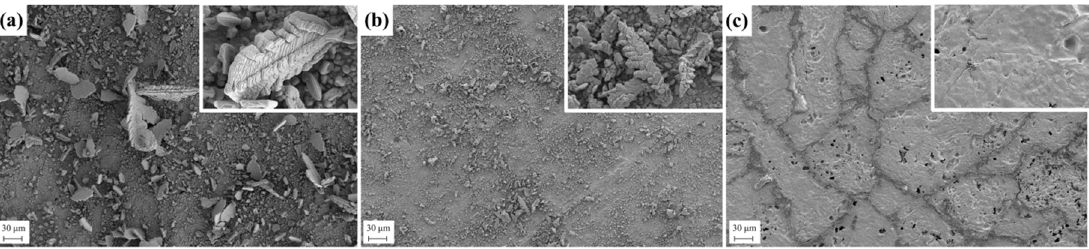
Figure 3. FE-SEM images (SE2, 30 μ m scale) of potentiostatic polarized zinc pellets: ( a ) uncoated, ( b ) 1 wt. % and ( c ) 5 wt. % ionomer-coated zinc particles in modified aqueous alkaline electrolytes ( ii : 4s-2).